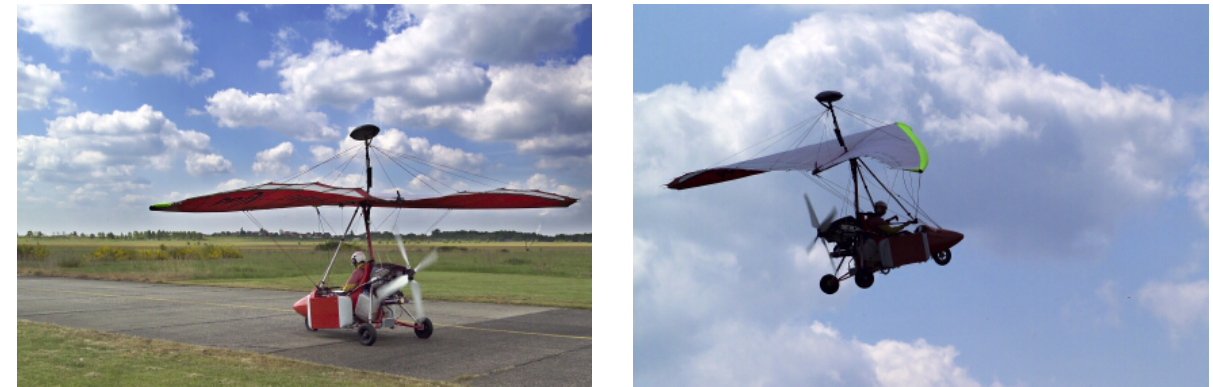
Figure 12. Operation of AVIS-2 on a microlight plane; the sensor is mounted on the both sides of the microlight (left